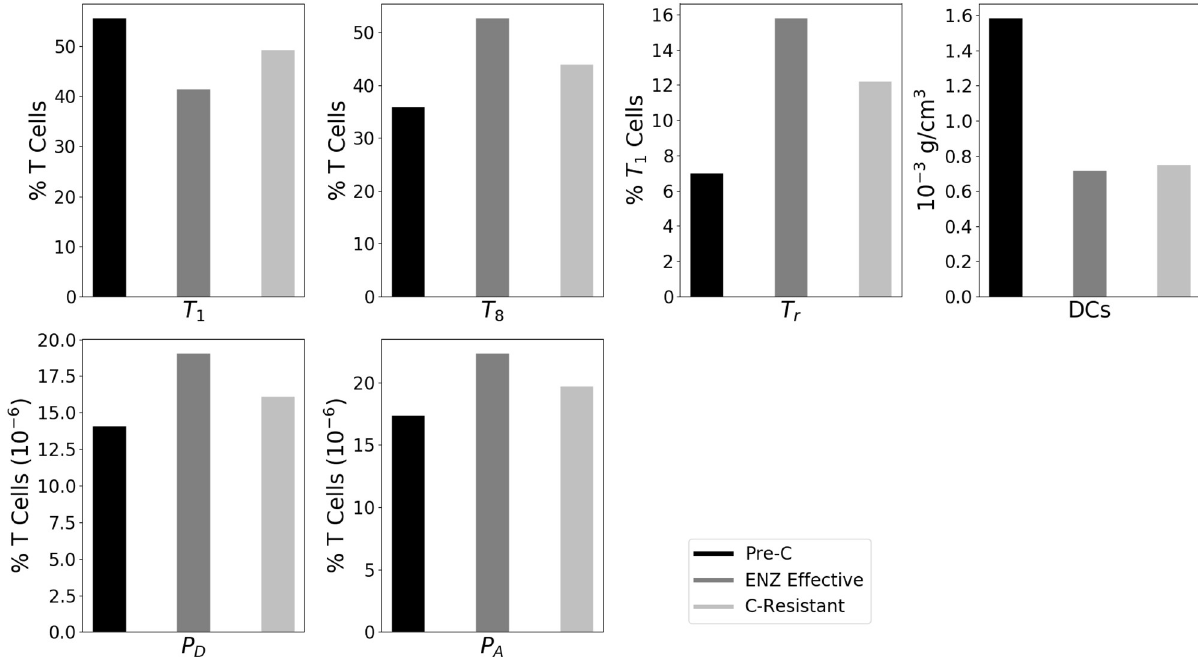
Fig 3. Cellular immune components of the pre-castration and post-castration within the tumor. All parameters are as in S1 File Tables 1 and 2. “Pre-C” represents the level of the species at the time when the tumor volume attains its first maximum before decline due to ENZ, with γ E = 10 − 7 g/ cm 3 � d, “ENZ-Effective” is the level of the species at the time when the tumor volume attains its lowest value under ENZ, and “C-Resistant” represents the level of the species at day 30 of treatment with ENZ, when androgen-resistance cells density ( M ) is at highest level.